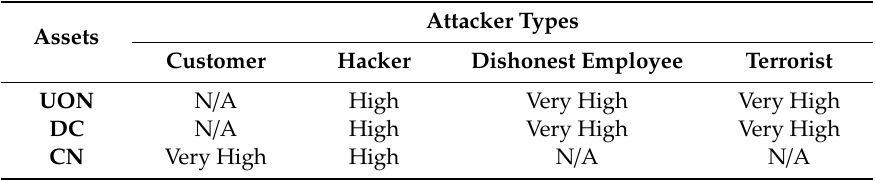
Table 2. Likelihood Levels for SMiShing Attack.